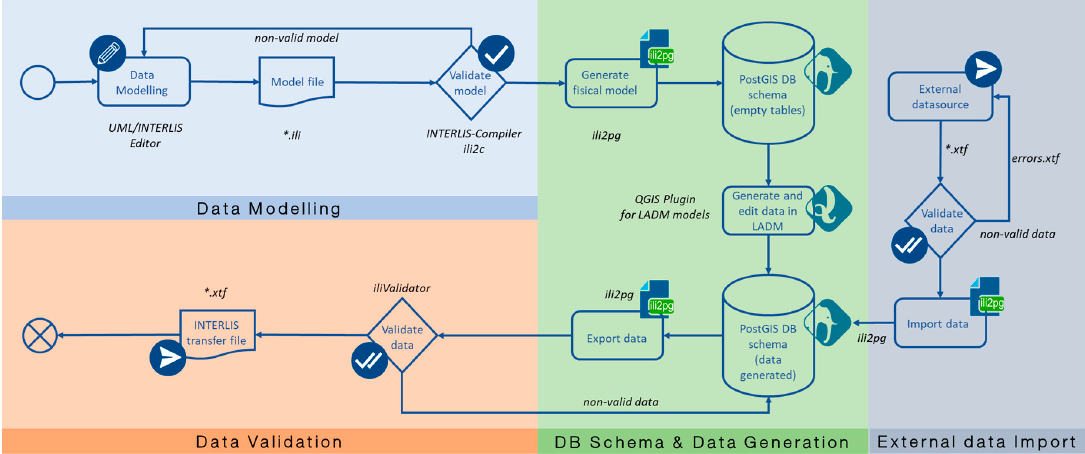
Figure 6. INTERLIS tools and workflow ([6], edited).